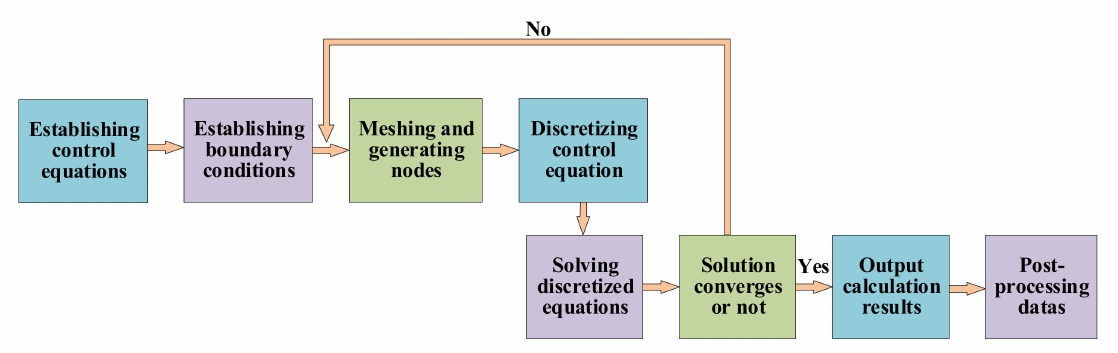
Figure 8. Solving process of numerical